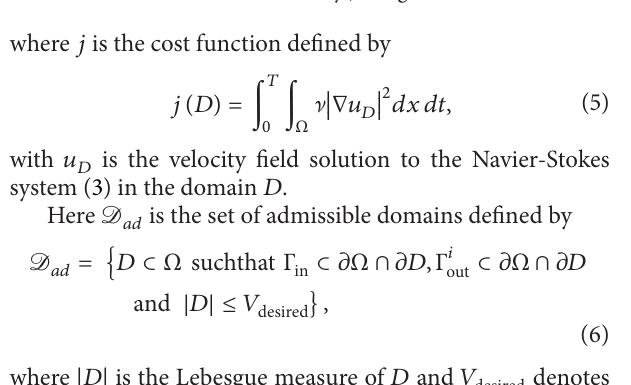
Figure 1: Cavity \